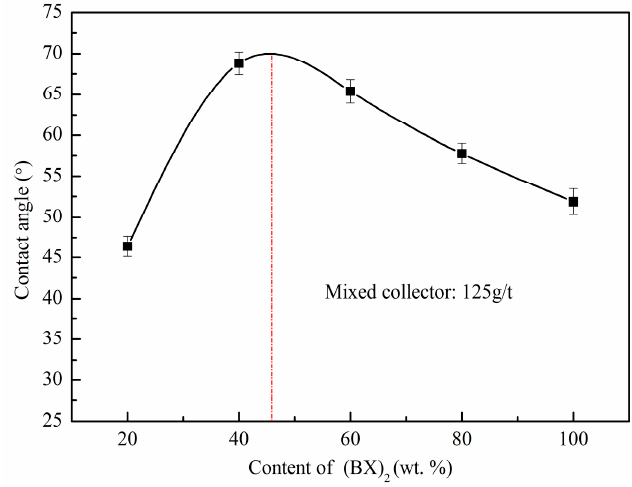
Figure 13. Contact angle vs. mass fraction of (BX) 2 for pyrrhotite with mixed collectors at pH 6.0.